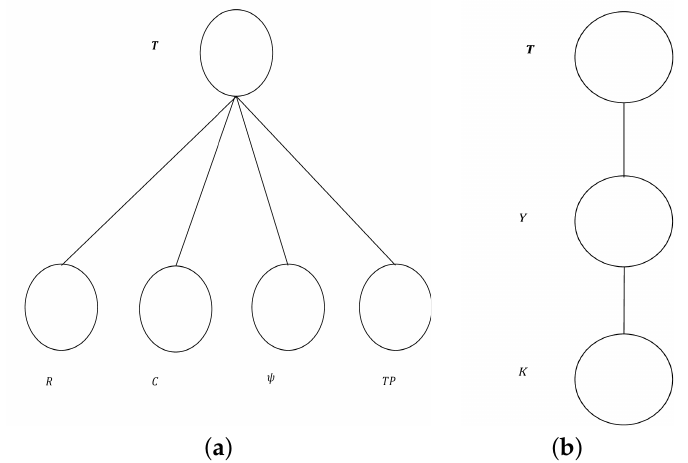
Figure 2. The graph model for the water network construction: ( a ) the general model; ( b ) the hierarchical